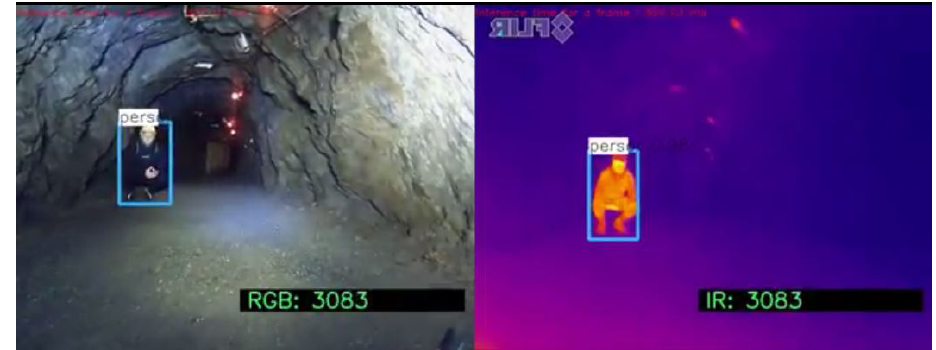
Figure 14. Human in squatting position—correct detection with algorithm